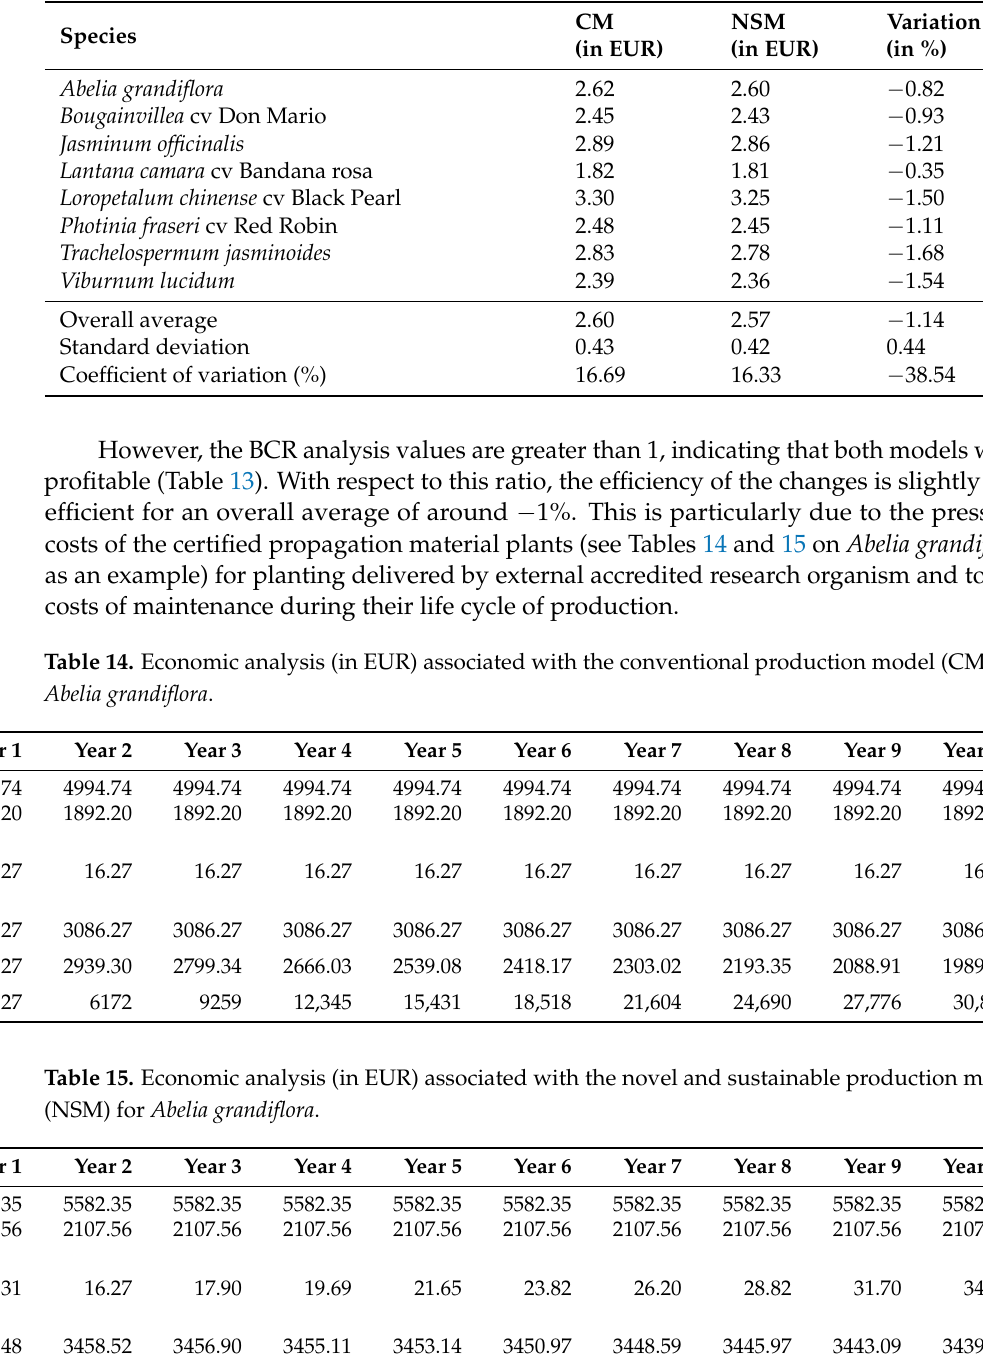
Table 13. Benefit–Cost Ratio (BCR) variation for two production models: conventional production model (CM) and novel and sustainable production model (NSM), among 8 selected ornamental species. A discount rate of 5% was used for both protocols, even if the production with NSM presumes a reduction in the risk of production of safer phytosanitary ornamental plants. The label values (in %) indicate the variation in BCR between the two models.